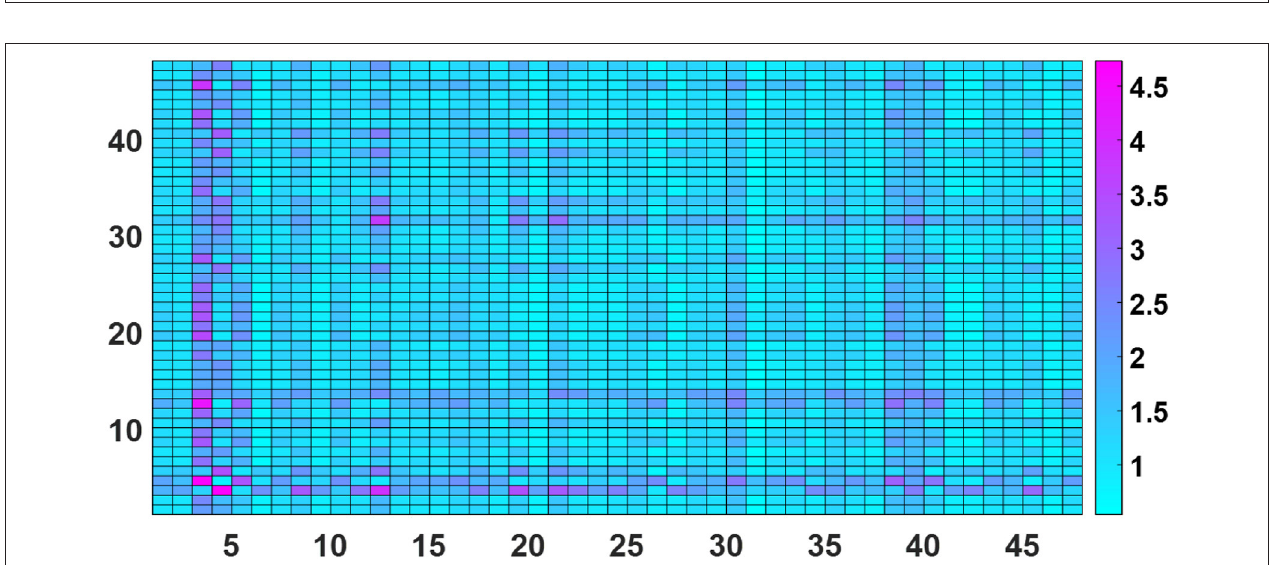
FIGURE 2 | Confusion matrix of mean-square errors (MSEs) created from the GPs: testing set. The MSE is normalized here such that, if the mean of the training data is used as a minimal model, the value of the MSE is 100, and can be interpreted as a percentage. Any value less than 100% thus represents captured